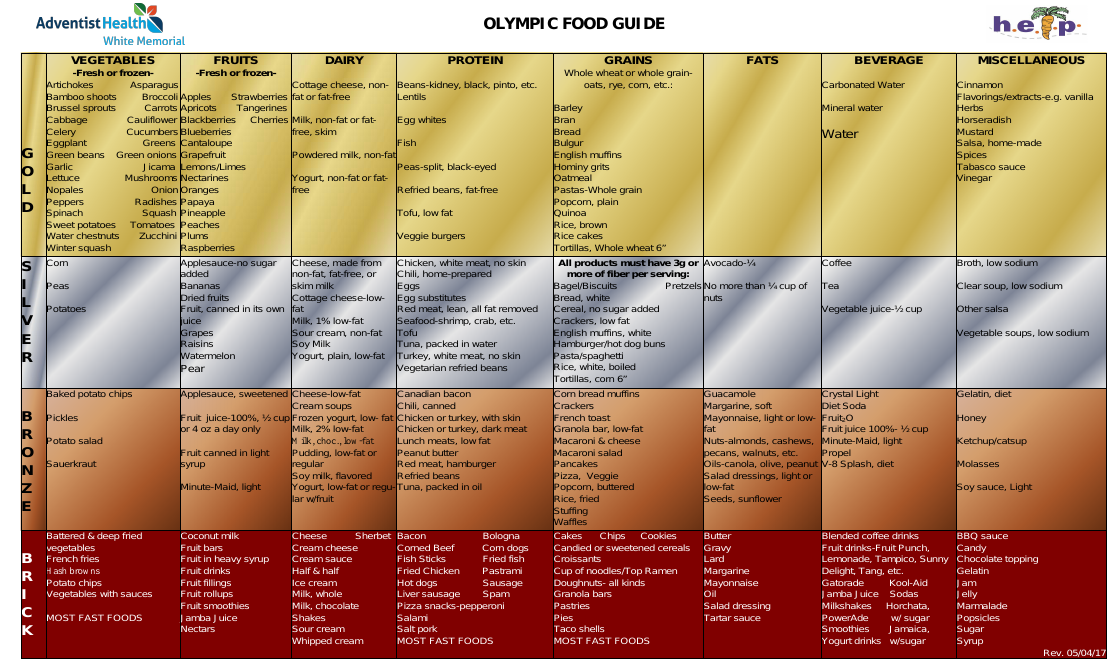
Figure 1. Tiered food guide for the Healthy Eating and Lifestyle Program (HELP) designed for Hispanic / Latino children ages 5–12 years who were overweight /